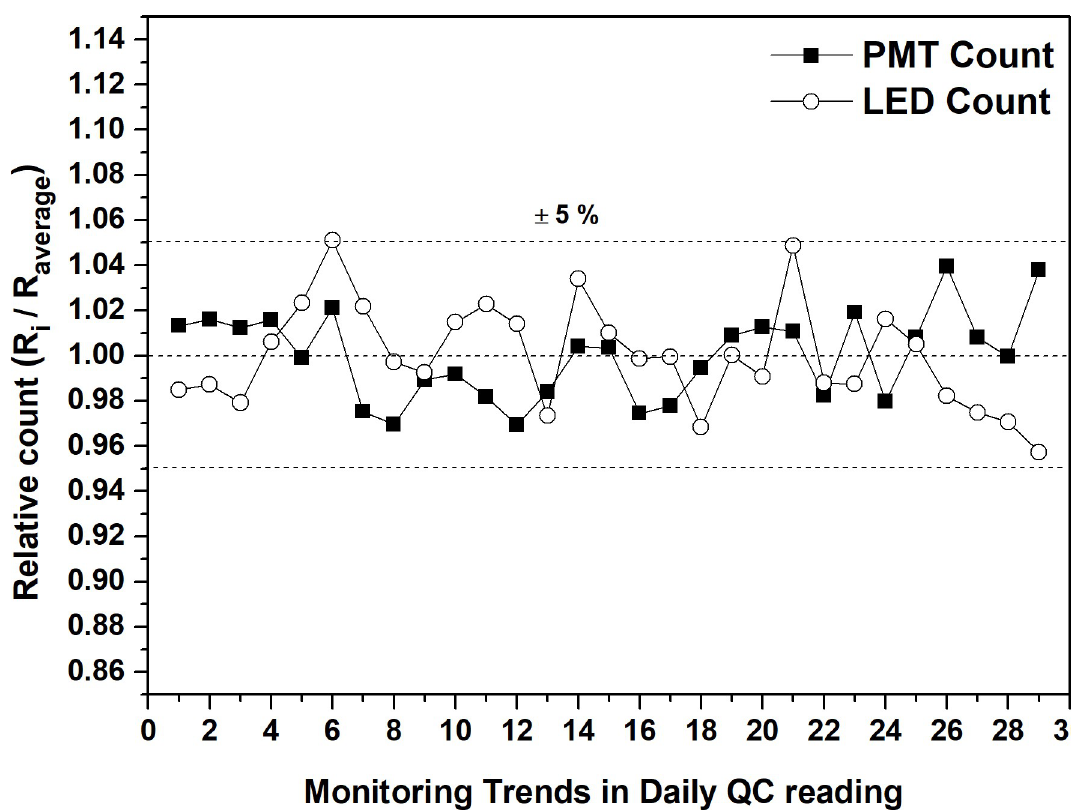
Fig 1. Monitoring trends of reader stability during our study, where R average is the average signal of the reading system during monitoring, and R denotes the ith i